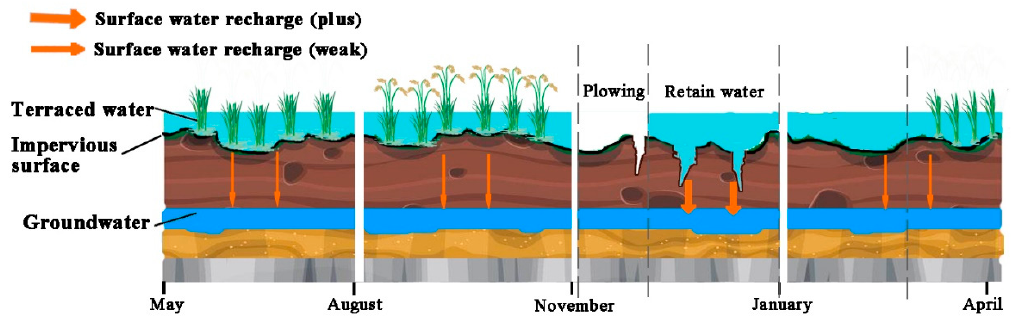
Figure 6. Spatial e ff ect on groundwater under the influence of farming Figure 6. Spatial effect on groundwater under the influence of farming activities.